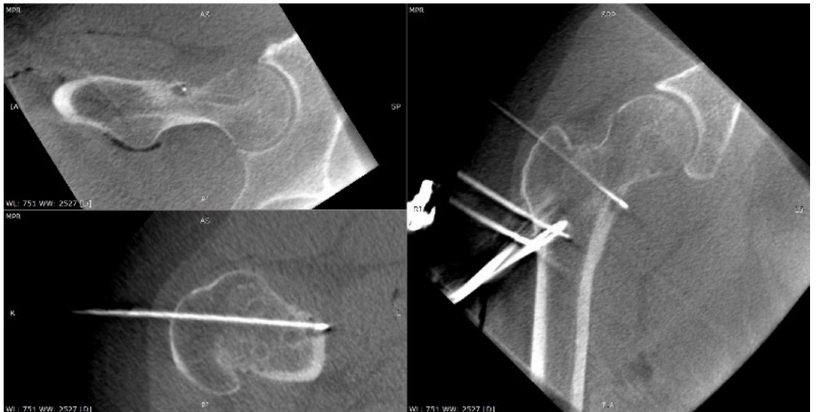
Figure 11. Intraoperative photographs during thermoablation with 3D navigation. Cannulated screws were unscrewed for the time of ablation, and reinserted after the